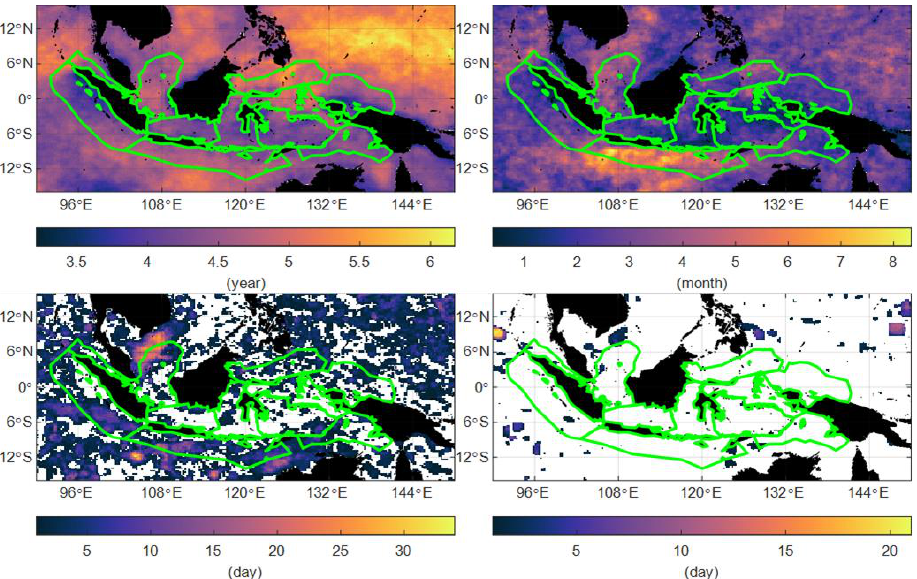
Figure 6. Total duration of MHWs throughout research period sorted by category.